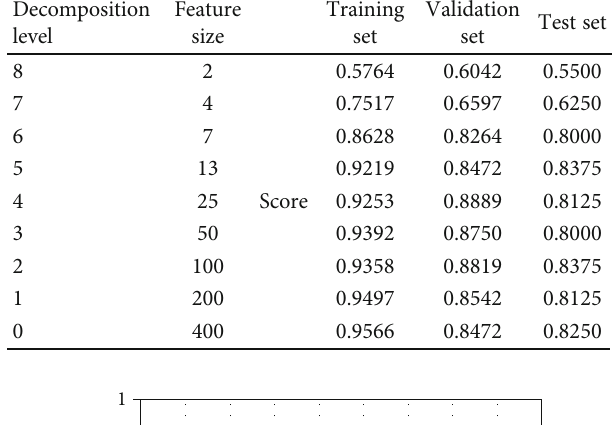
Figure 7: The accuracy scores for the SVM according to the decomposition level. Table 2: The sensitivity analysis of the decomposition level using the 800 raw data: 400 oil production rates and 400 water cuts. Decomposition